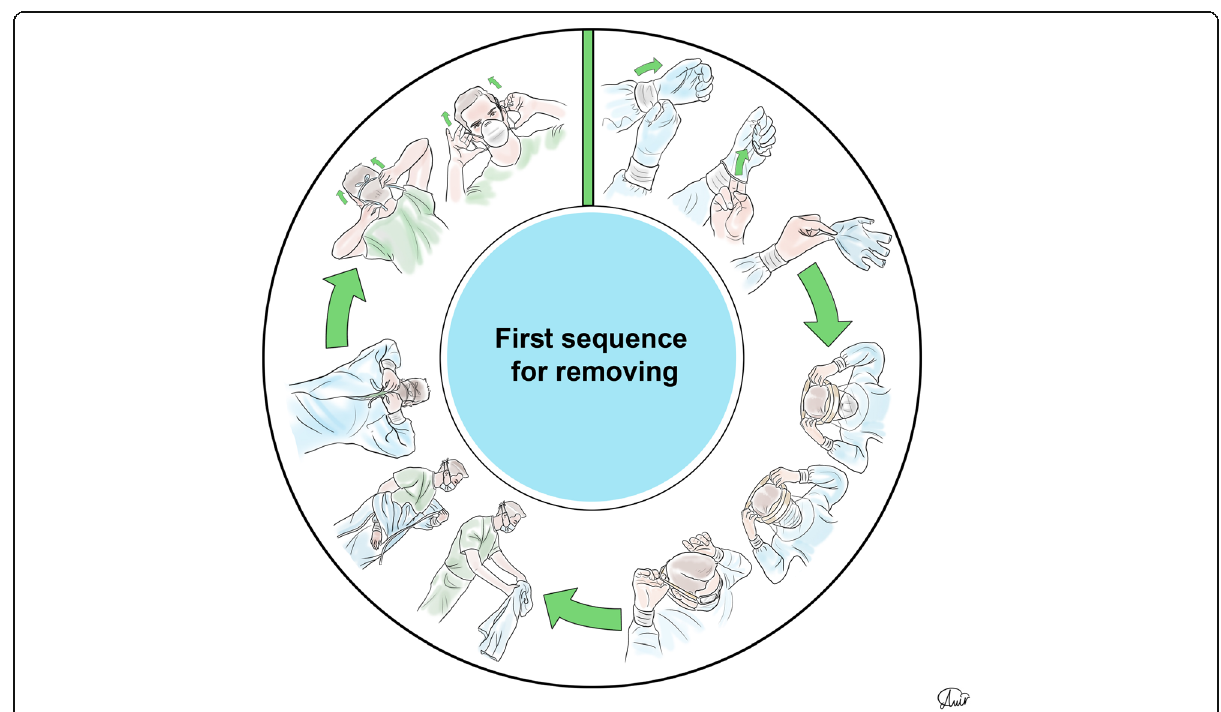
Fig. 3 Personal protection equipment doffing first order